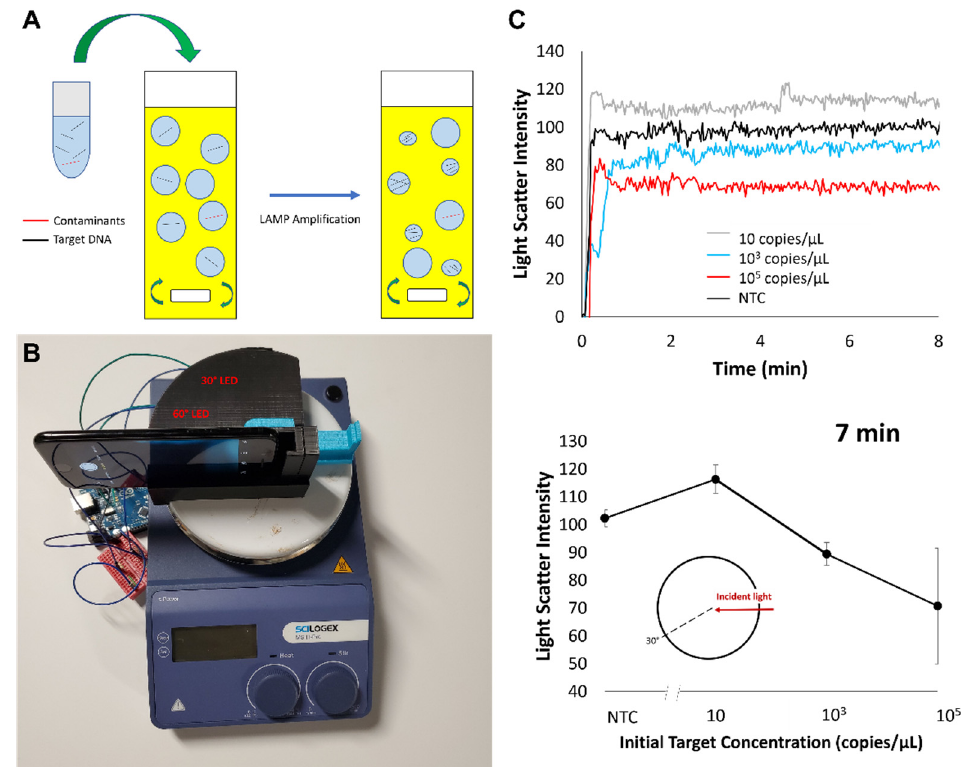
Figure 8. Day et al.’s emulsion LAMP. ( A ) Compartmentalization of emulsion LAMP reactions. Re-